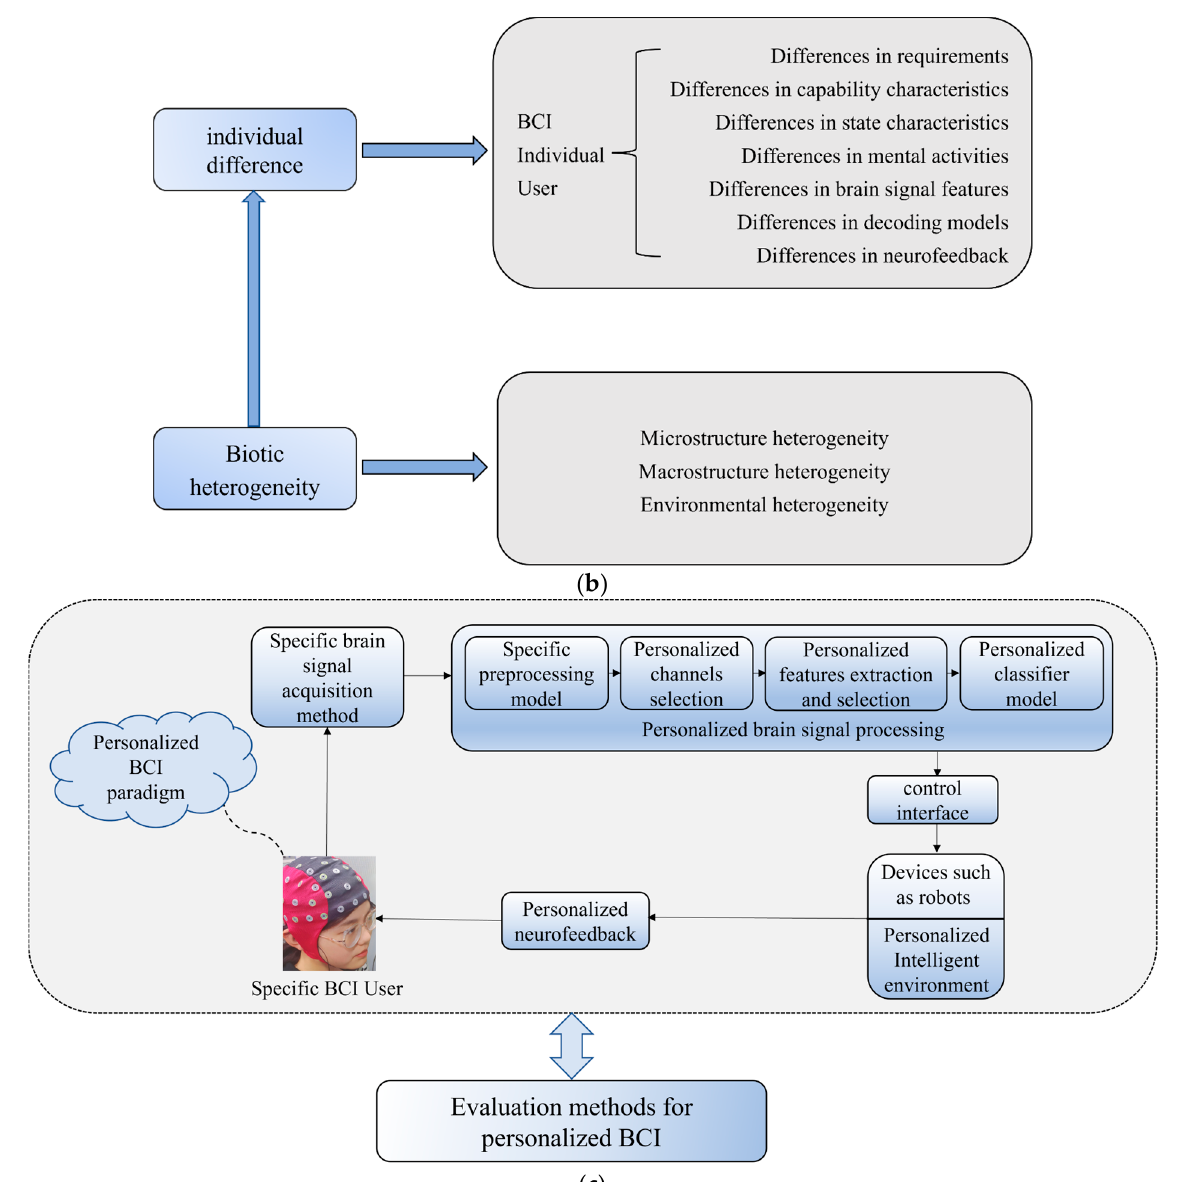
Figure 2. ( a ) Individual differences between BCI users; ( b ) developing and designing personalized BCIs based on general BCIs; ( c ) personalized BCI system diagram.